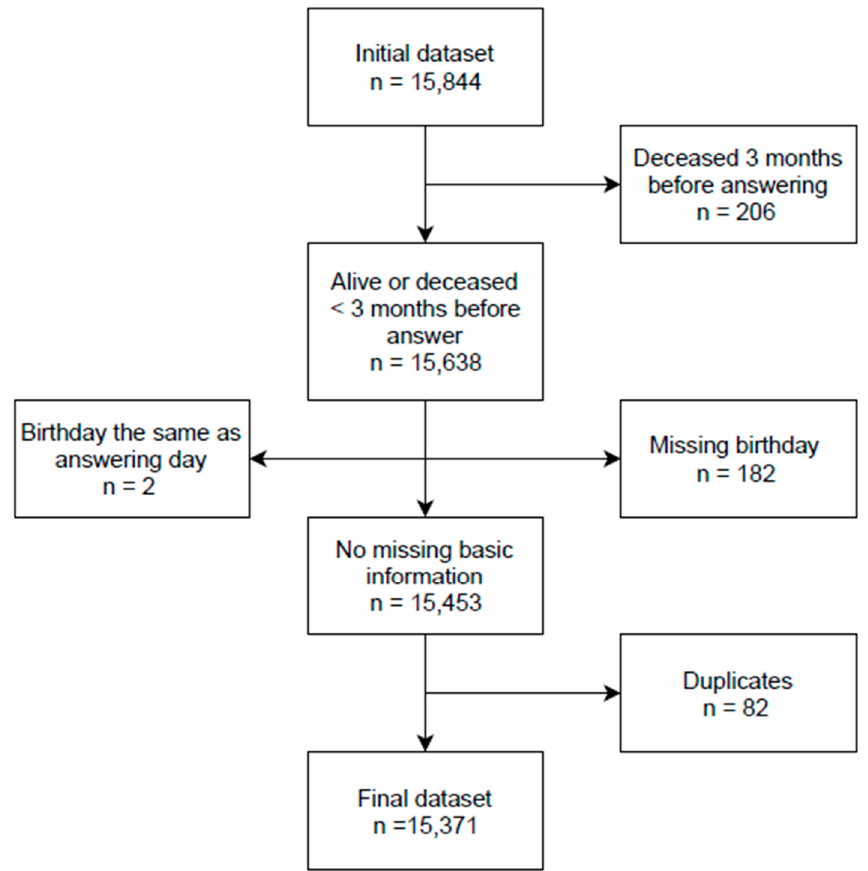
Figure 1. Flow chart of the study population and sample size for dog personality and behavior studies.